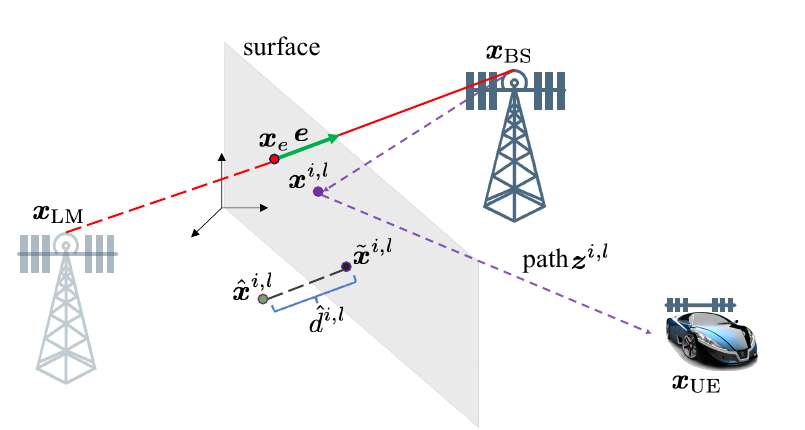
Figure 5. The principle of finding ˜ x i , l and calculating ˆ d i , l using z i , l , x LM and x BS